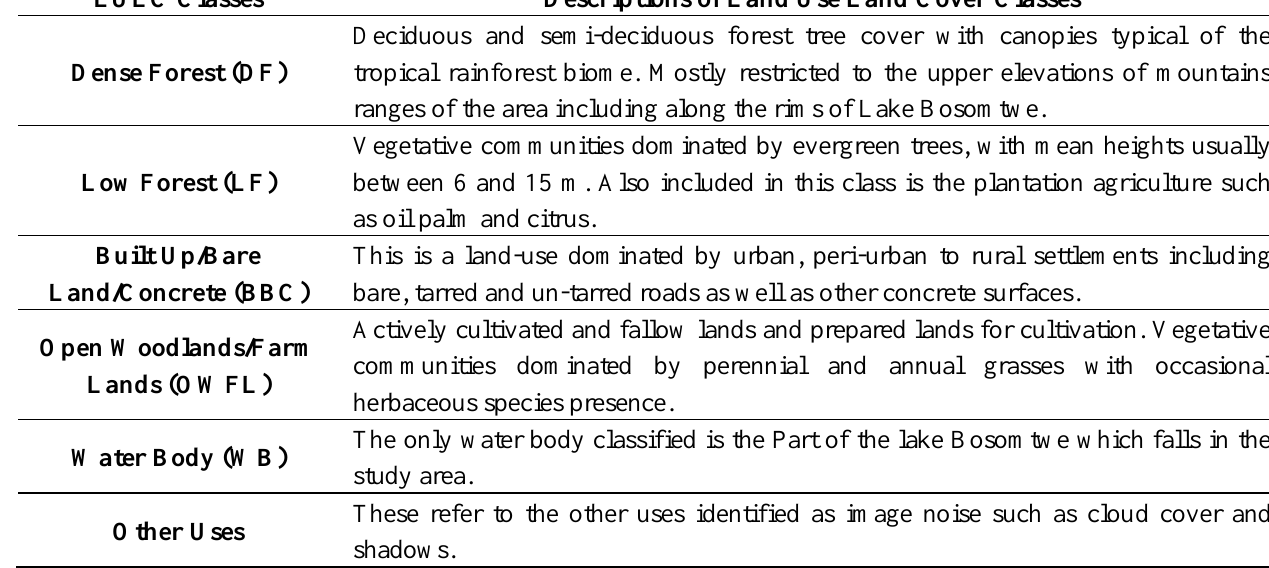
Table 9. LULC classification